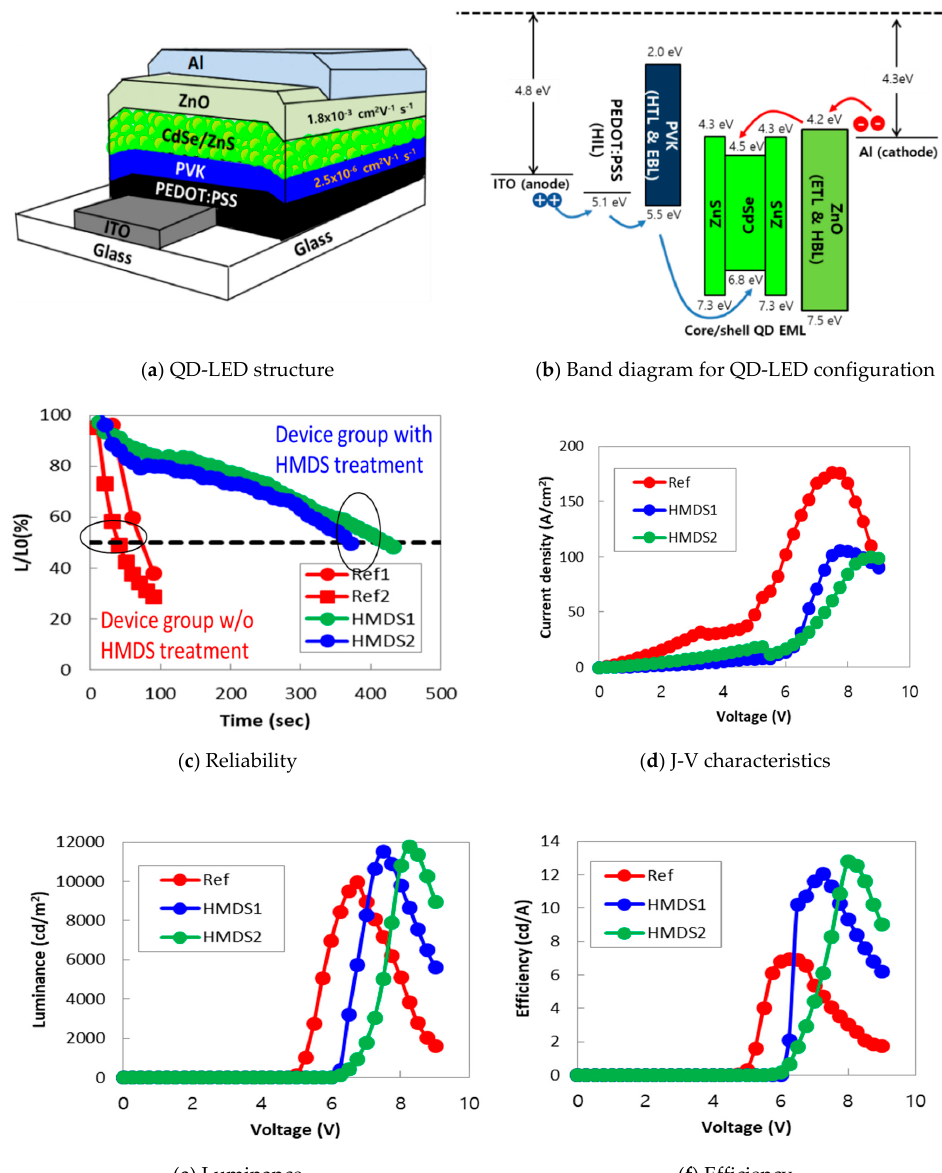
Figure 2. The roles of HMDS coating of the CdSe/ZnS core-shell quantum dot on the improvement of QD-LED characteristics. To quickly confirm the effects of HMDS coating, we tested the QD-LEDs without the glass capping layer for the optical and electrical characterizations. ( a ) A schematic of QD-LED with newly proposed HMDS-coated the CdSe/ZnS core-shell quantum dot. ( b ) The energy levels of QD-LED and the effects of the HMDS treatment of QD-LEDs on ( c ) the reliability, ( d ) J-V characteristics, ( e ) luminance, and ( f ) efficiency. Where, Ref means QD-LED without HMDS, HMDS1 and HMDS2 mean QD-LEDs blended with HMDS.